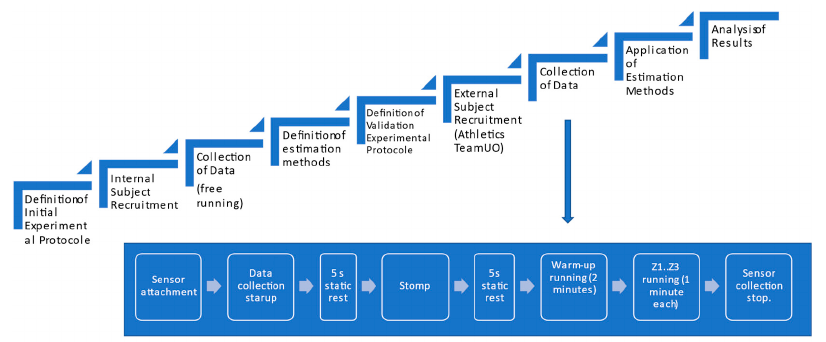
Figure 3. Experimental flowchart.